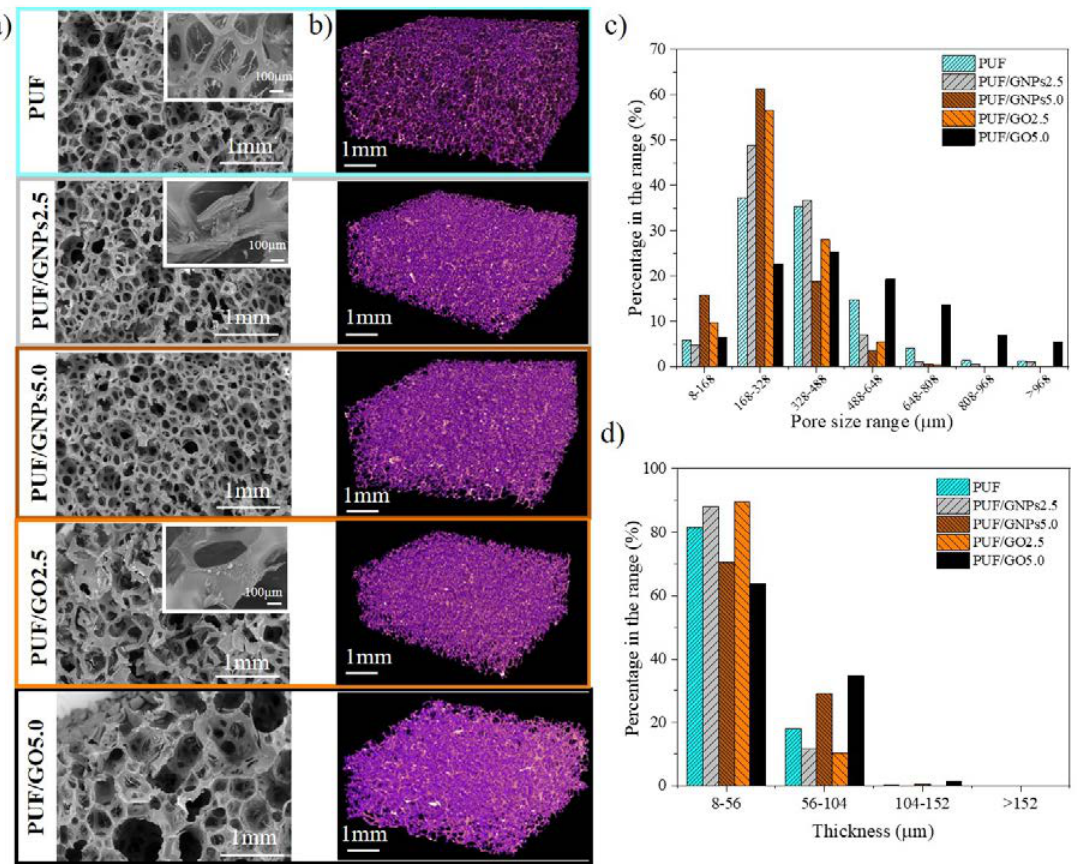
Figure 3. ( a ) SEM images, ( b ) 3D µCT rendering, ( c ) pore size distribution, and ( d ) cell wall thickness distribution for PUF, PUF/GNPs2.5, PUF/GNPs2.5, PUF/GO2.5, and PUF/GO5.0.